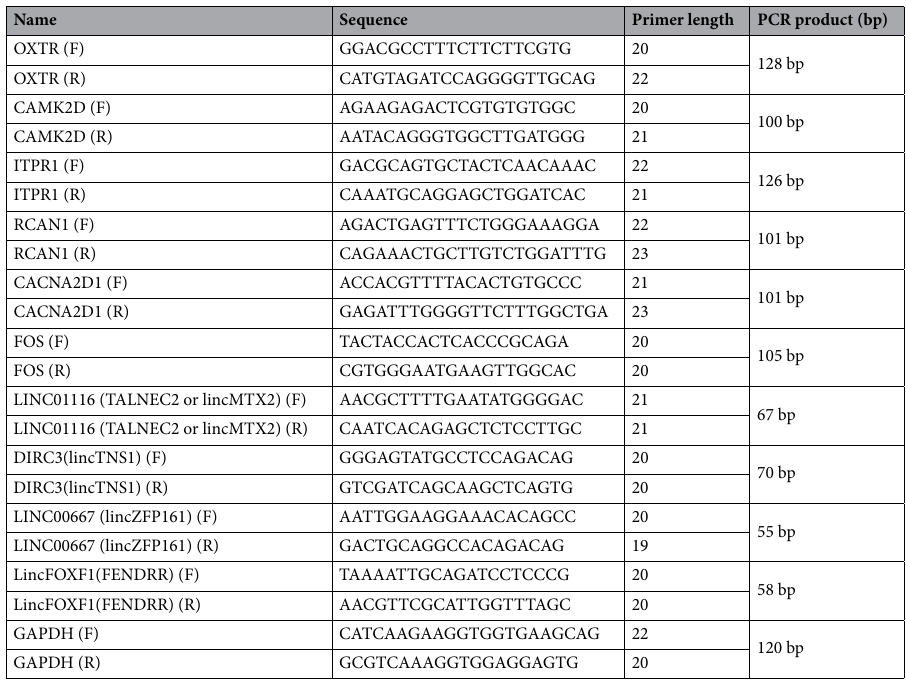
Table 1. Primers and amplicons